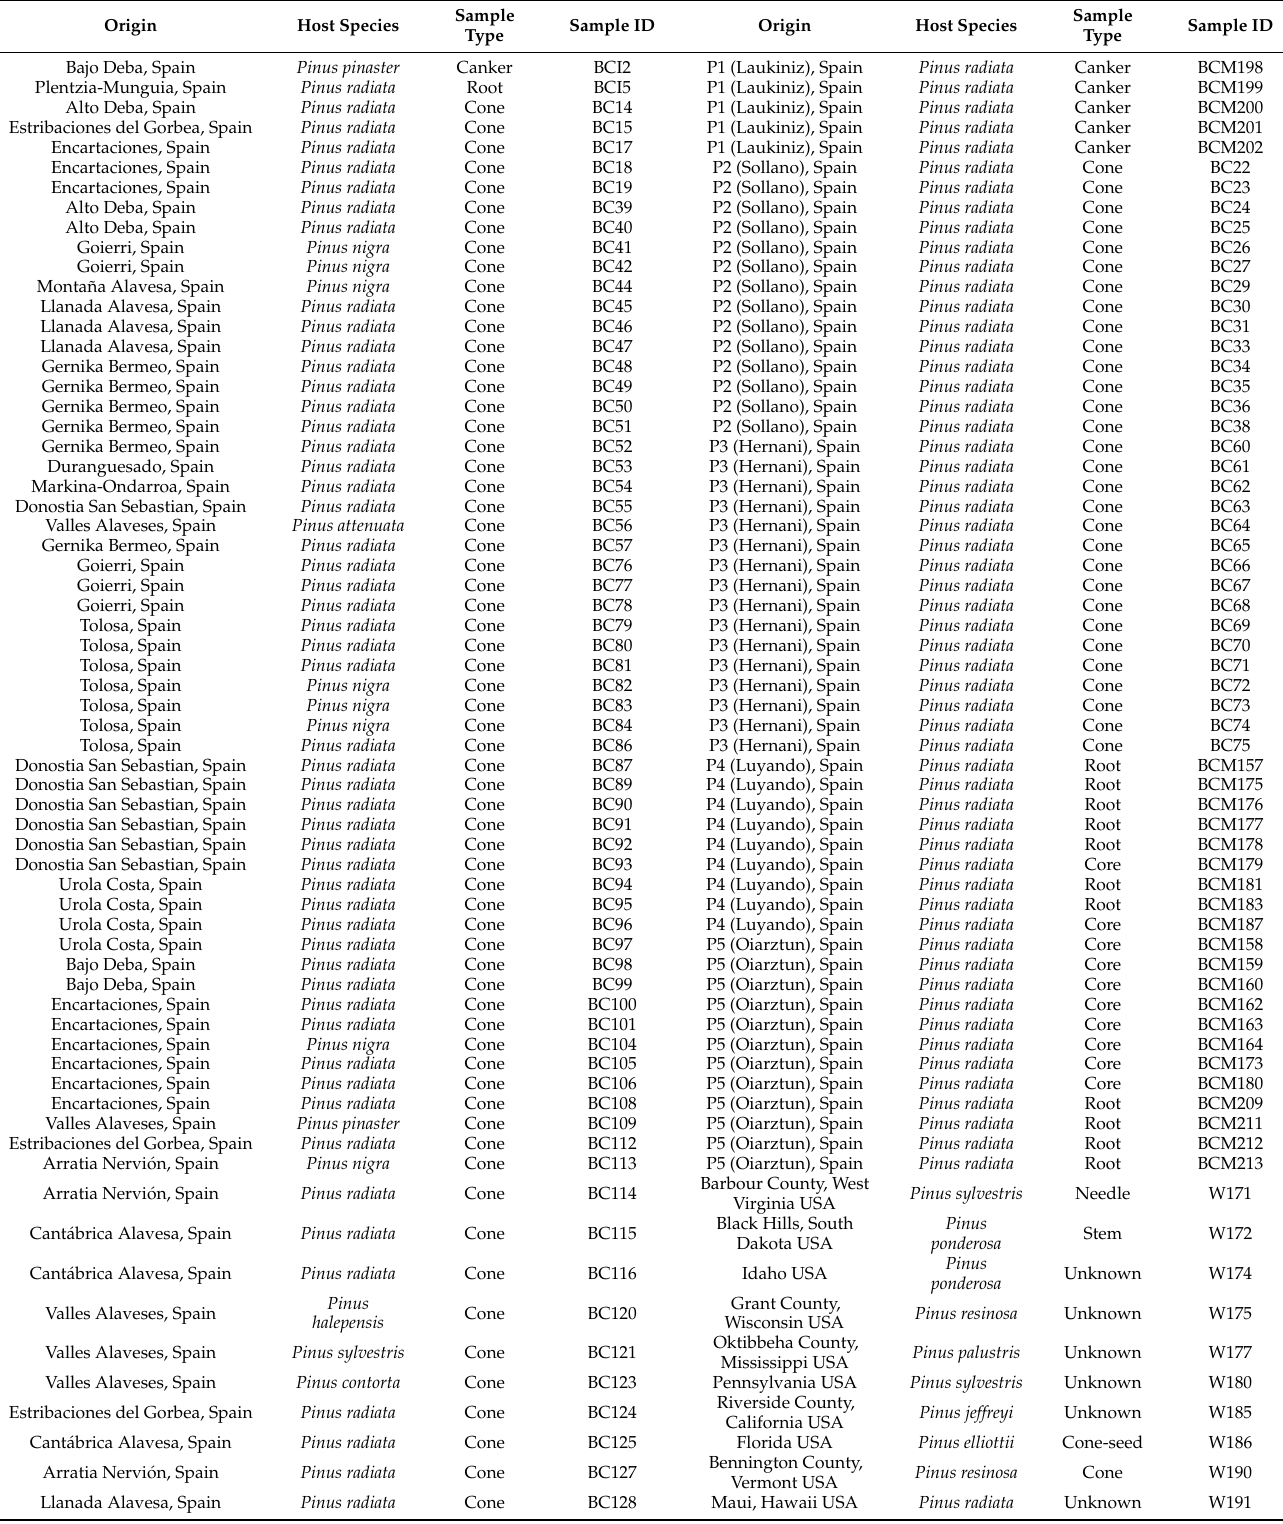
Table 1. Diplodia sapinea isolates used in this study: origin, host species, sample type and strain identification code.